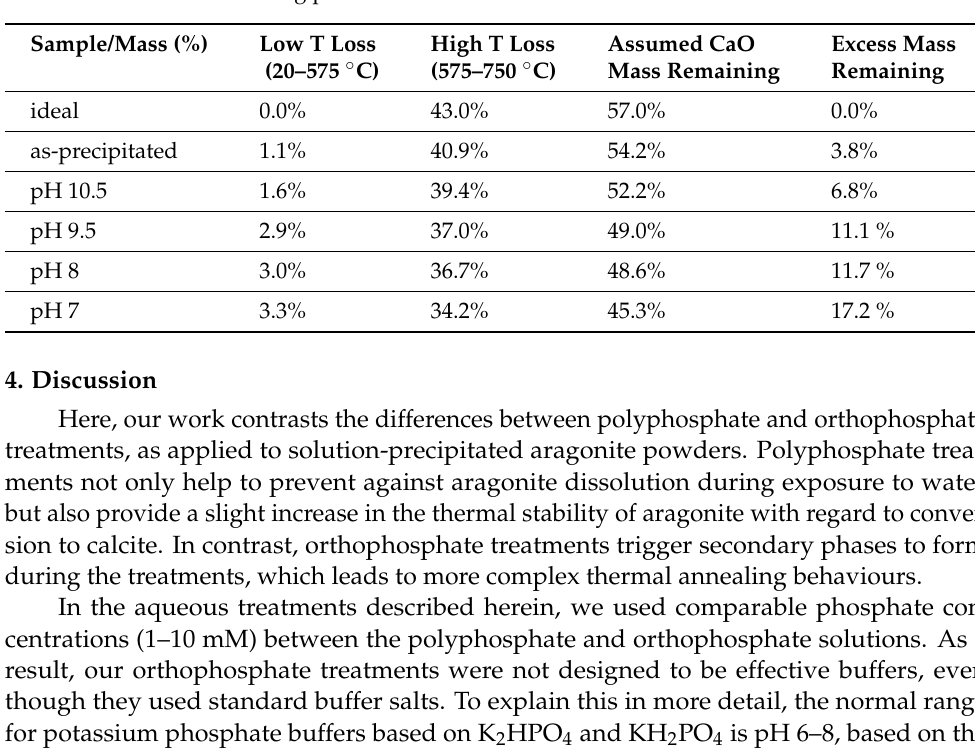
Table 1. Summary of % mass losses during TGA measurements for powders with orthophosphate treatments at different starting pH